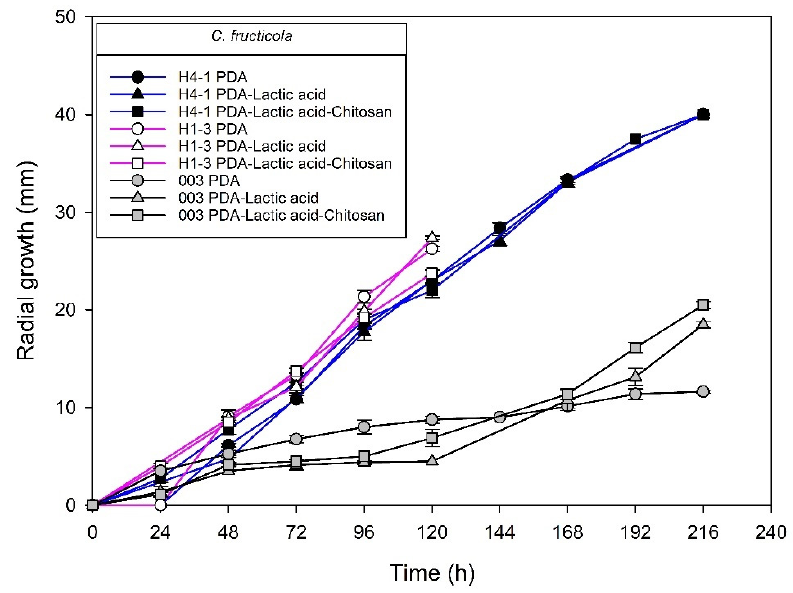
Figure 4. Colletotrichum fructicola species isolated from anthracnose of mango (H4-1, H1-3, and 003). Kinetics of radial growth (mm) in medium PDA, PDA-lactic acid (0.05 M), and PDA-lactic acid (0.05 M) with 1 g L − 1 chitosan at 25 ◦ C.